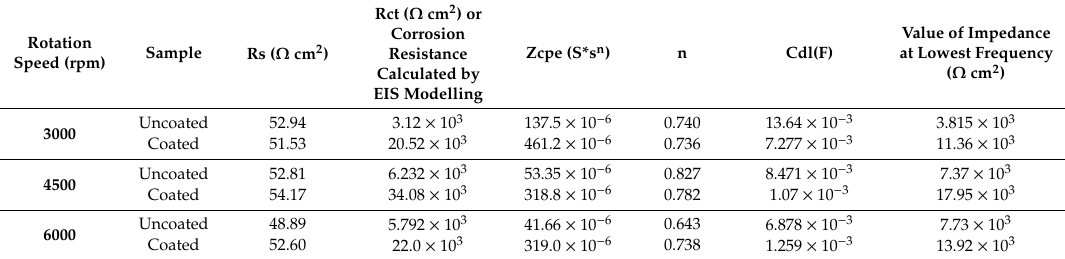
Figure 9. Electrical equivalent circuit model for fitting the EIS results. Table 2. Electrochemical parameters gained from EIS